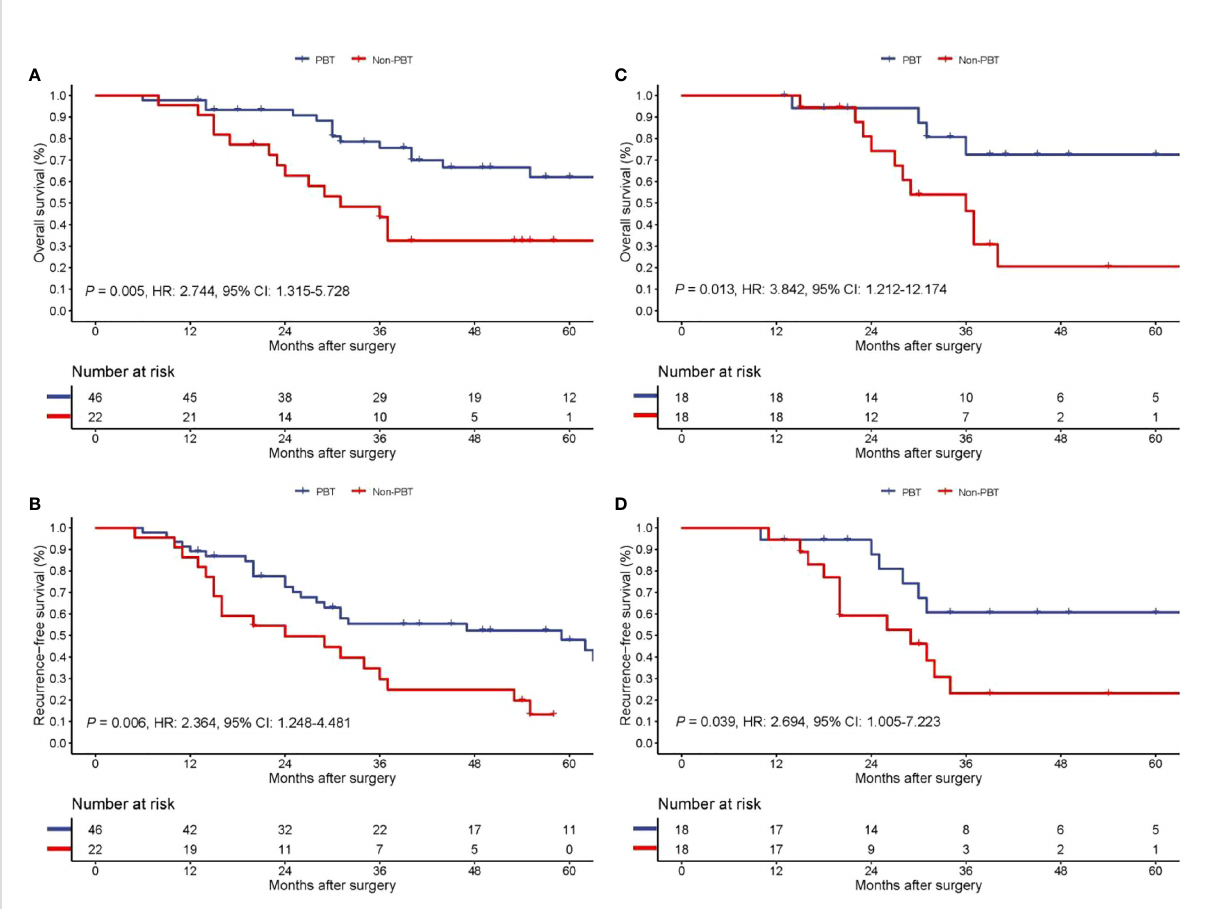
FIGURE 2 Kaplan − Meier curves of overall survival (A) and recurrence-free survival (B) between the PBT and non-PBT group among patients with early stage (8th AJCC stage I) pCCA treated with curative resection before PSM. Kaplan − Meier curves of overall survival (C) and recurrence-free survival (D) between the PBT and non-PBT group among patients with early stage (8th AJCC stage I) pCCA treated with curative resection after PSM. CI, con fi dence interval; HR, hazard ratio; PBT, perioperative blood transfusion; PSM, propensity score